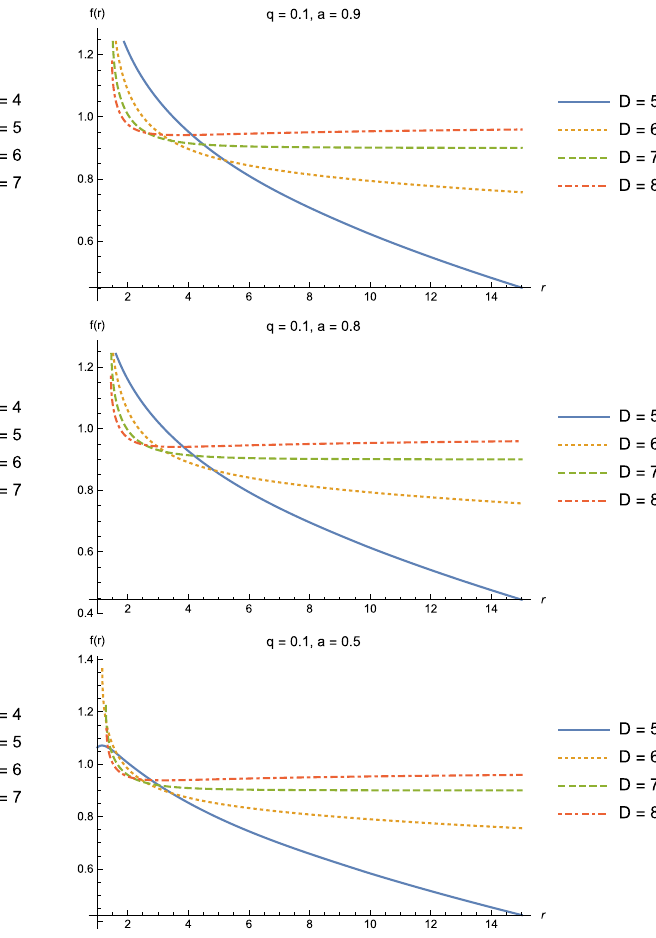
Fig. 2 The function f ( r ) in D-dimensional gravity for ω q = − 2 / 3, a = 0 . 8, M = 1 and for differents values of q and D Fig. 3 Thefunction f